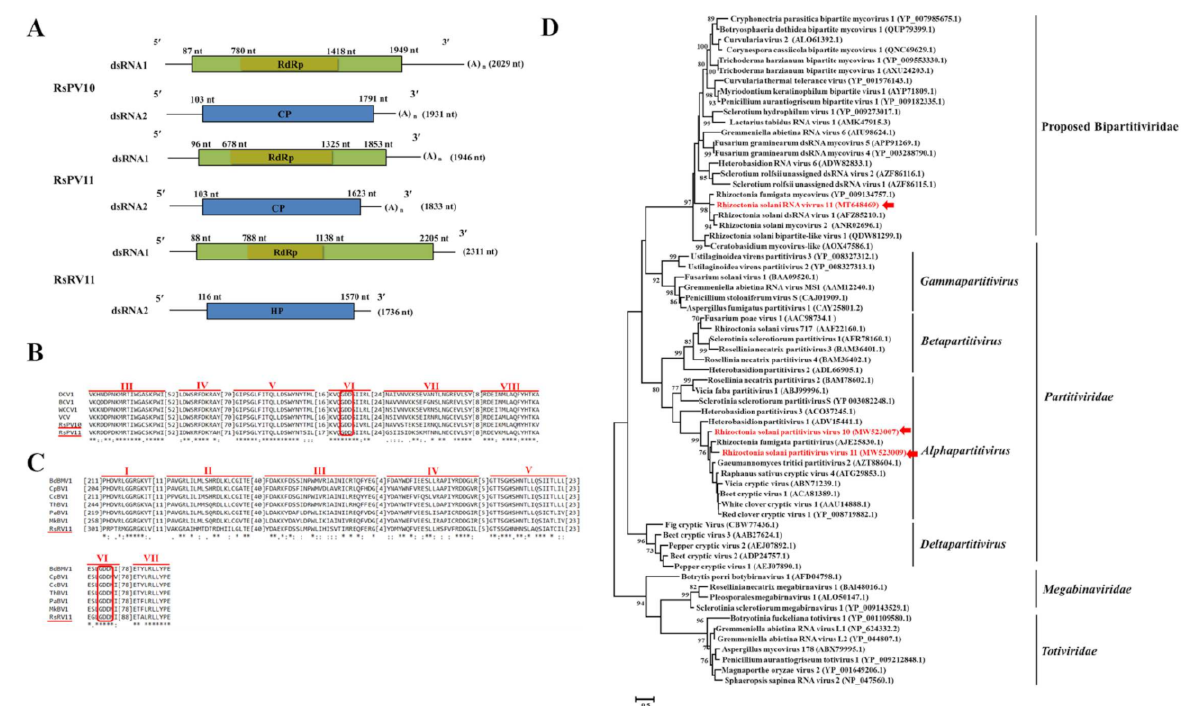
Figure 4. Genome organization, multiple alignments of amino acid (aa) sequence of RNA-dependent RNA polymerase (RdRp), and phylogenetic analysis of aa sequences of RdRp of Rhizoctonia solani partitivirus 10 (RsPV10), Rhizoctonia solani partitivirus 11 (RsPV11), and Rhizoctonia solani RNA virus 11 (RsRV11). ( A ) Schematic diagrams illustrating the genome organization of RsPV10, RsPV11, and RsRV11. Each of the three mycoviruses possess two double-stranded RNAs (dsRNAs), namely dsRNA1 (the longer dsRNA) and dsRNA2 (the shorter dsRNA). The dsRNA1 and dsRNA2 in RsPV10 and RsPV11 encode RdRp and coat protein (CP), respectively, while the dsRNA1 and dsRNA2 in RsRV11 encode RdRp and a hypothetical protein (HP), respectively. The 3’-terminus of dsRNA1 and dsRNA2 in RsPV10 and RsPV11 possess a poly adenylate (polyA) sequence, which is not found in the 3’-terminus of either dsRNA1 or dsRNA2 of RsRV11. ( B ) Multiple aa alignments of RdRp in RsPV10, RsPV11, and four other representative partitiviruses in which six conserved motifs (III to VIII) are indicated. ( C ) Multiple aa alignments of RdRp in RsRV11 and six other representative proposed bipartitiviruses in which seven conserved motifs (I to VII) are indicated. The highly conserved GDD tripeptide is present in partitiviruses and bipartitiviruses and is indicated by red boxes. “*” indicates identical amino acids, “:” indicates high chemically similar amino acids, and “.” indicates low chemically similar amino acids. ( D ) Phylogenetic analysis of aa sequences of RdRp in RsPV10, RsPV11, RsRV11, and 29 representative members of Partitiviridae , seven members of Totiviridae , and four members of Megabirnaviridae as well as 22 members of proposed family, Bipartitiviridae. The dendrogram indicates that RsPV10 and RsPV11 cluster in the genus Alphapartitivirus , while RsRV11 clusters in the proposed family, Bipartitiviridae. The names and GenBank accession numbers of reference mycoviruses are listed at Table